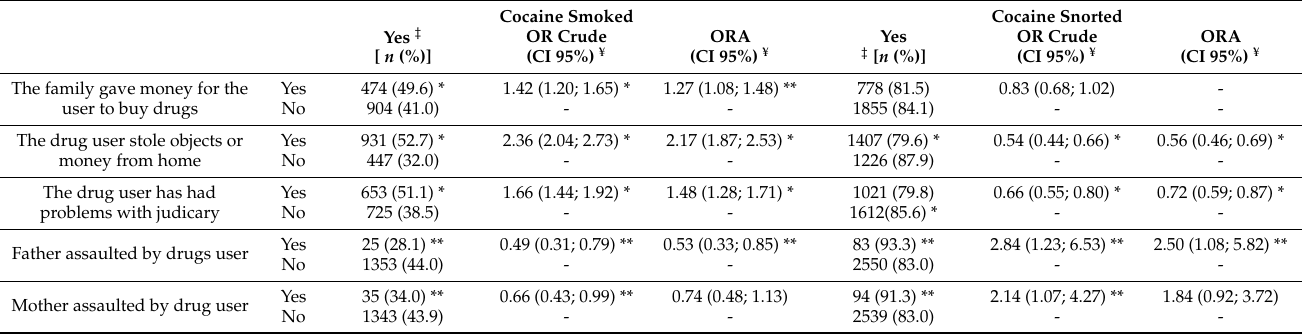
Table 3. Domestic violence reported by